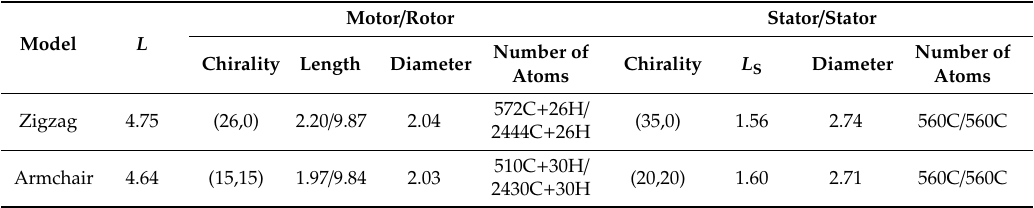
Figure 4. The initial model for testing the transmission torque moment from motor to rotor. ( a ) Configuration of the transmission model. The left short carbon nanotube acts as a motor with constant input rotational frequency of ω M . The right part is a nano-bearing from double walled carbon nanotubes (CNTs). The rotor is confined by the two same concentric stators. The rotational frequency of the rotor, i.e., ω R , is the output rotation. At the right edge of the rotor, an active resistant torque moment, M r , is applied for reducing the value of ω R . All the tubes are concentric with the same axis of Z. The essential geometrical factors are as Gap = 1.5 nm being the distance between the motor and the left stator. L S is the length of a stator. L is the distance between the two stators. Axial commensurate CNTs are used to form an armchair model from armchair tubes (with C-C bonds as edges) or a zigzag model from zigzag tubes (with uniformly distributed atoms as edges). The neighboring edges of motor and rotor with an initial distance of d = 0.5 nm are hydrogenated. Detailed parameters are listed in Table 5. ( b ) Free body diagram of the rotor. M M is the driving moment from the motor. M S1 and M S2 are from the two stators. Table 5. Parameters of the rotation transmission nanosystem with different models shown in Figure 4. Dimension unit: nm.